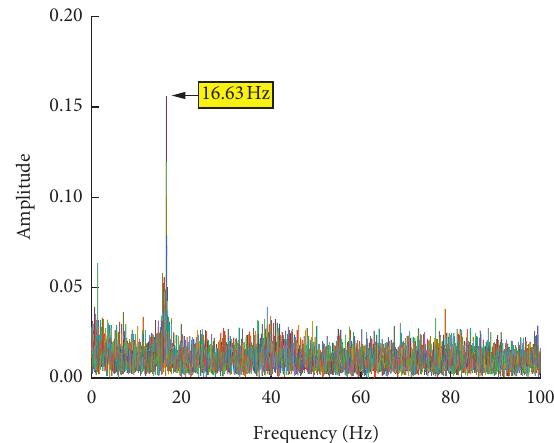
Figure 6: White noise spectrum